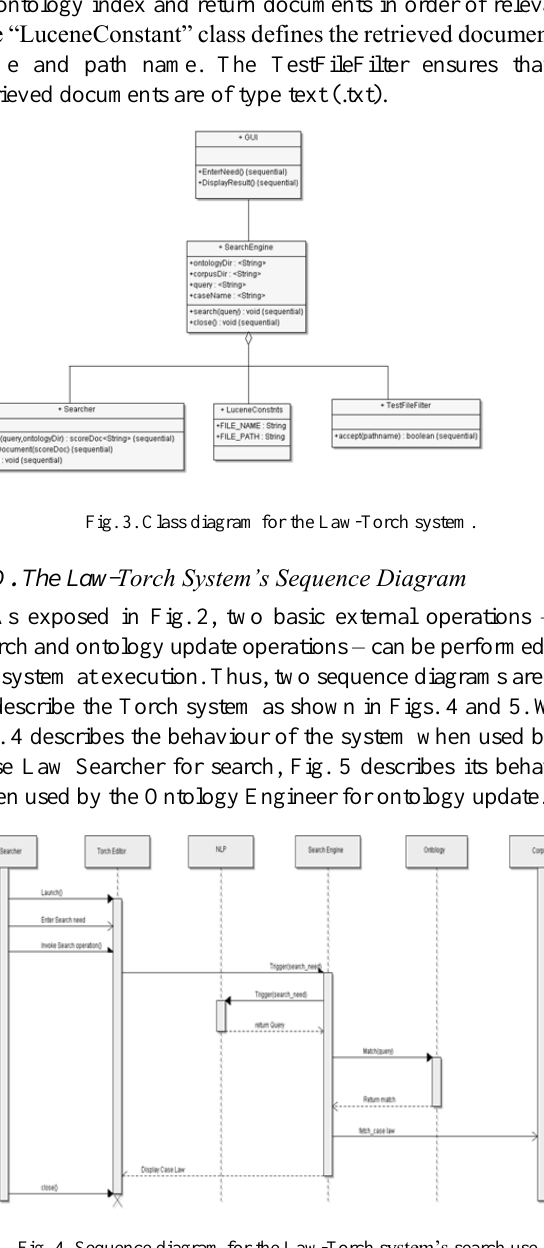
Fig. 4. Sequence diagram for the Law-Torch system’s search